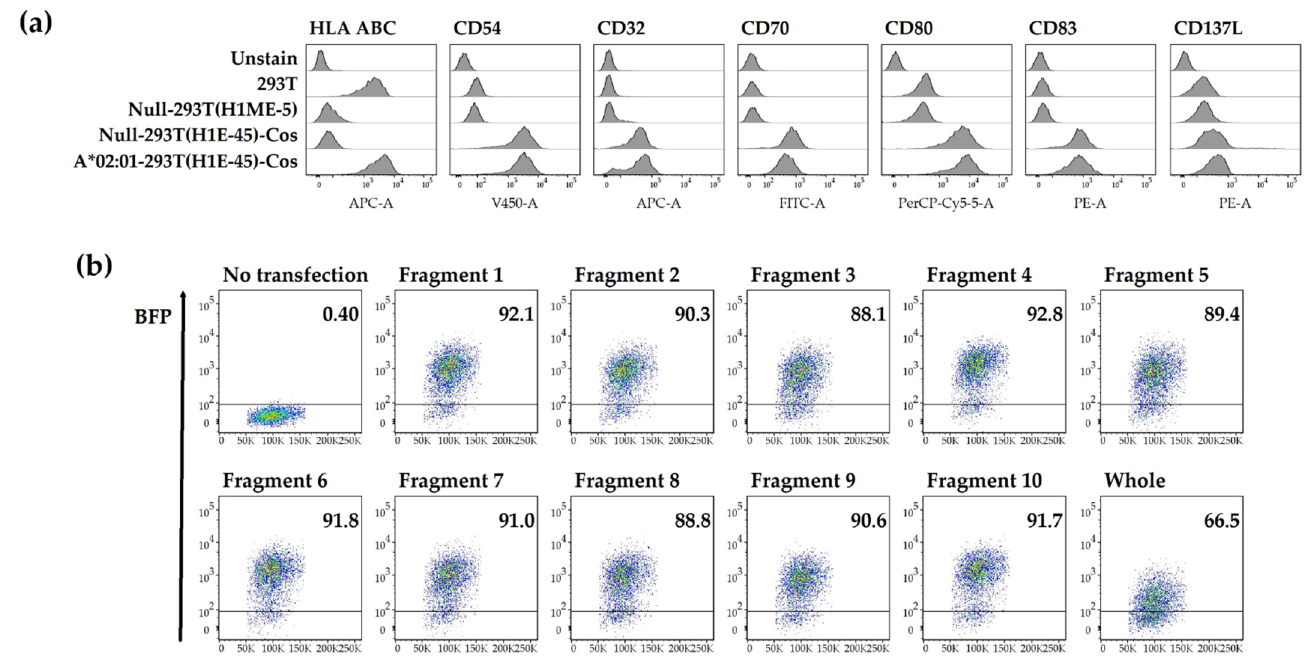
Figure 2. Transfer of mRNA including pp65 whole and fragment antigens to aAPCs expressing a single HLA class I allotype. ( a ) HLA and co-stimulatory molecules (CD54, CD32, CD70, CD80, CD83 and CD137L) expression in the HEK293T cell line were measured by flow cytometry. A*02:01- 293T(H1E-45)-Cos is to express HLA-A*02:01 in Null-293T(H1E-45)-Cos. ( b ) The expression of BFP co-expressing pp65 antigen in A*02:01-293T(H1E-45)-Cos cells were measured by flow cytometry.